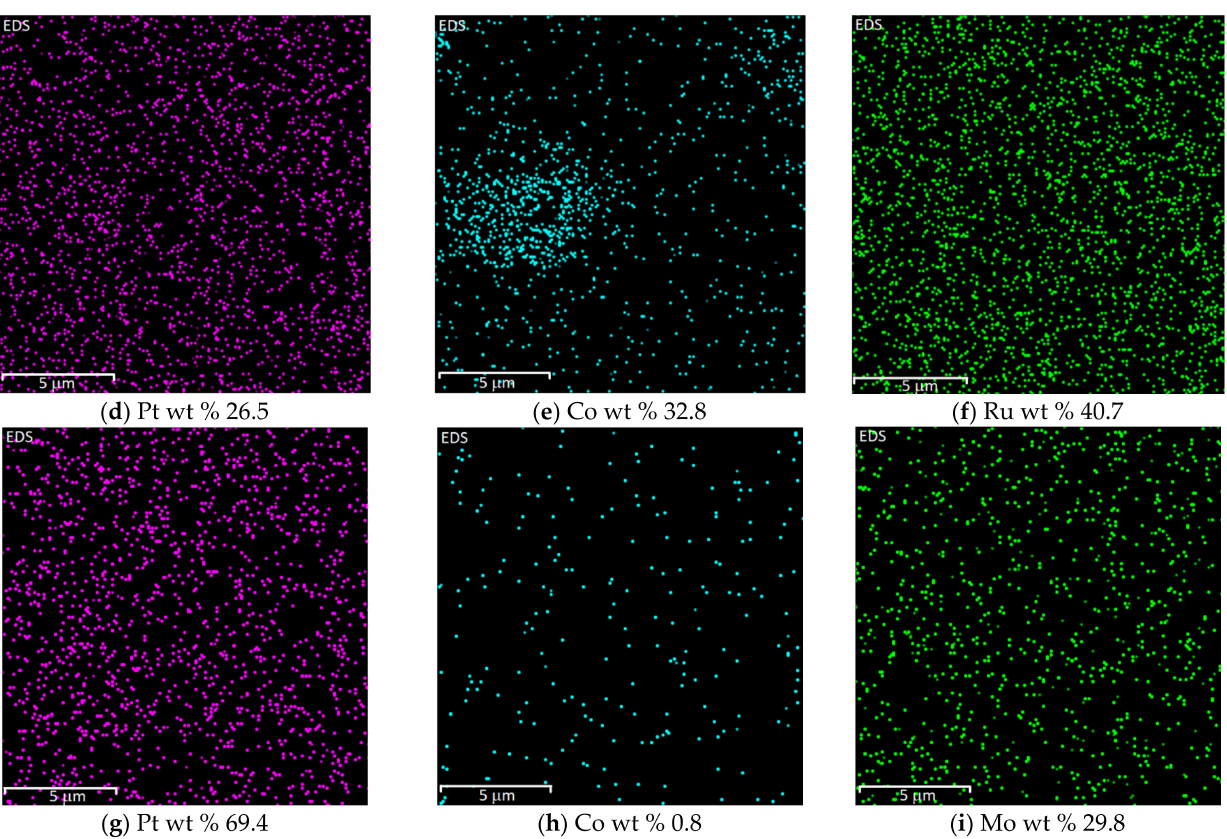
Figure 3. Distribution of metals in PtCoMn(1:3:1)/GR ( a – c ), PtCoRu(1:2:2)/GR ( d – f ), and PtCoMo(7:2:1)/GR ( g – i ) catalysts obtained by EDX analysis.